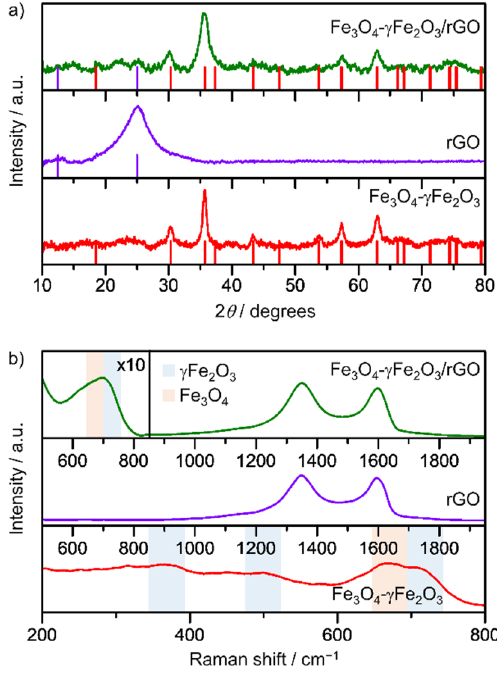
Figure 2. ( a ) X-ray diffractograms and ( b ) Raman spectra of the rGO sheets, clusters of Fe 3 O 4 - γ Fe 2 O 3 nanoparticles, and Fe 3 O 4 - γ Fe 2 O 3 /rGO hybrid. The boxed region in ( b ) is scaled by a factor of 10.